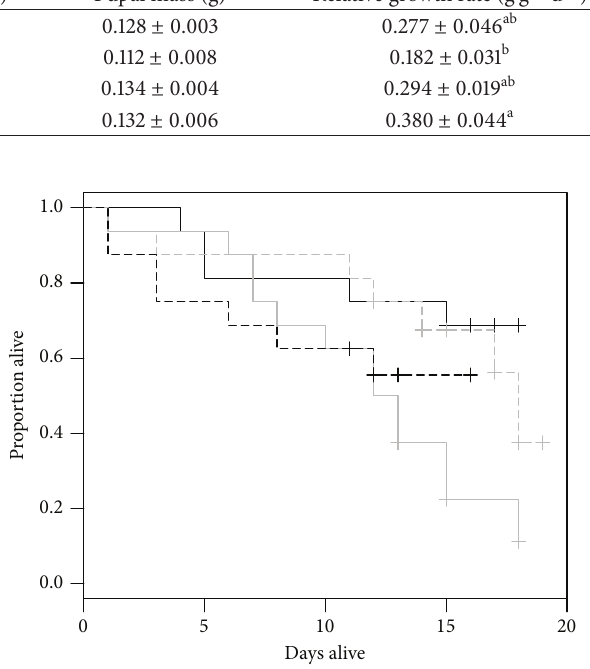
Figure3:Kaplan-Meiersurvivalestimatesof P.rapae caterpillarsfed commercial cabbage (solid black), rosette A. petiolata (dash grey), flowering A. petiolata (solid grey), or commercial mustard greens (dash